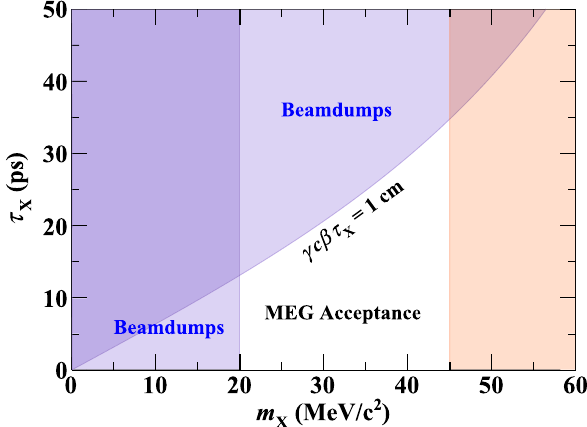
Fig. 3 Allowed X particle parameter space (white). The blue region has already been excluded [35] and the red shaded region on the right ( m X (cid:2) 45 MeV/c 2 ) is inaccessible to